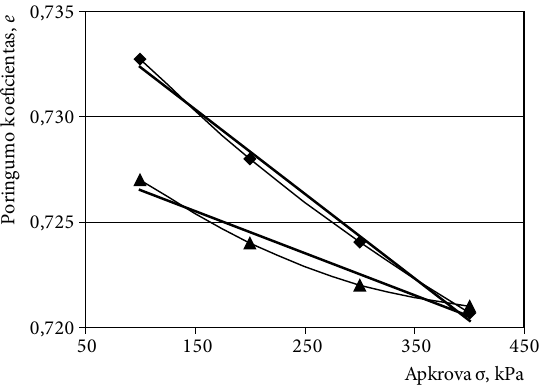
10 pav. Tiesinė poringumo koeficiento priklausomybė Fig. 10. Linear realation of void ratio versus loading